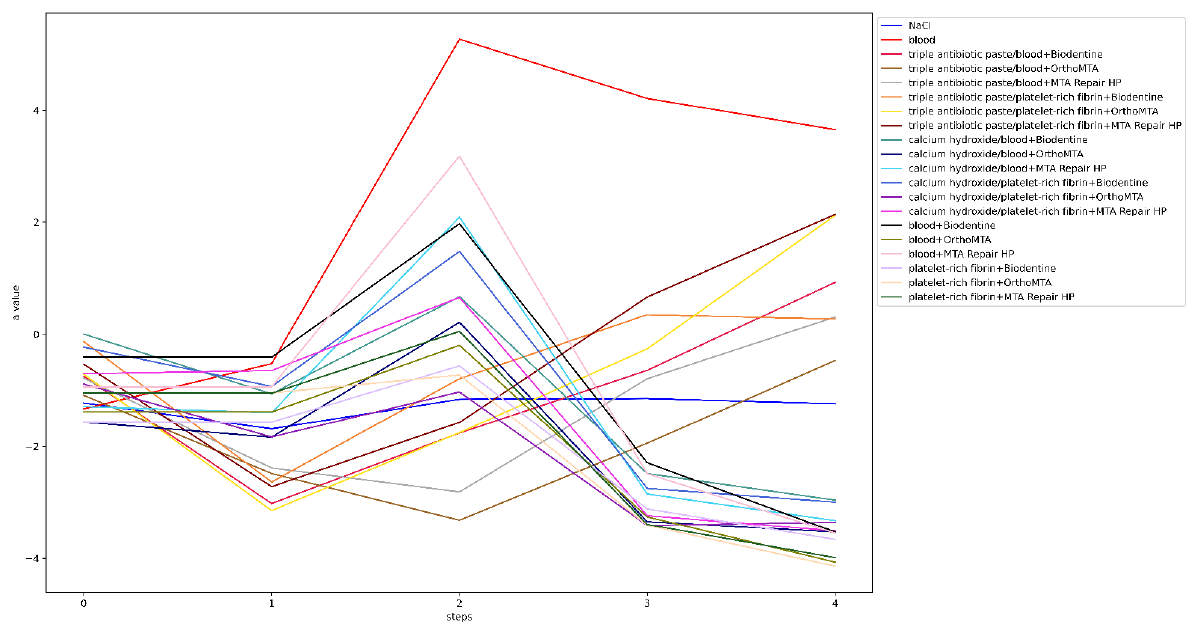
Figure 6. Values of L for all groups and steps.